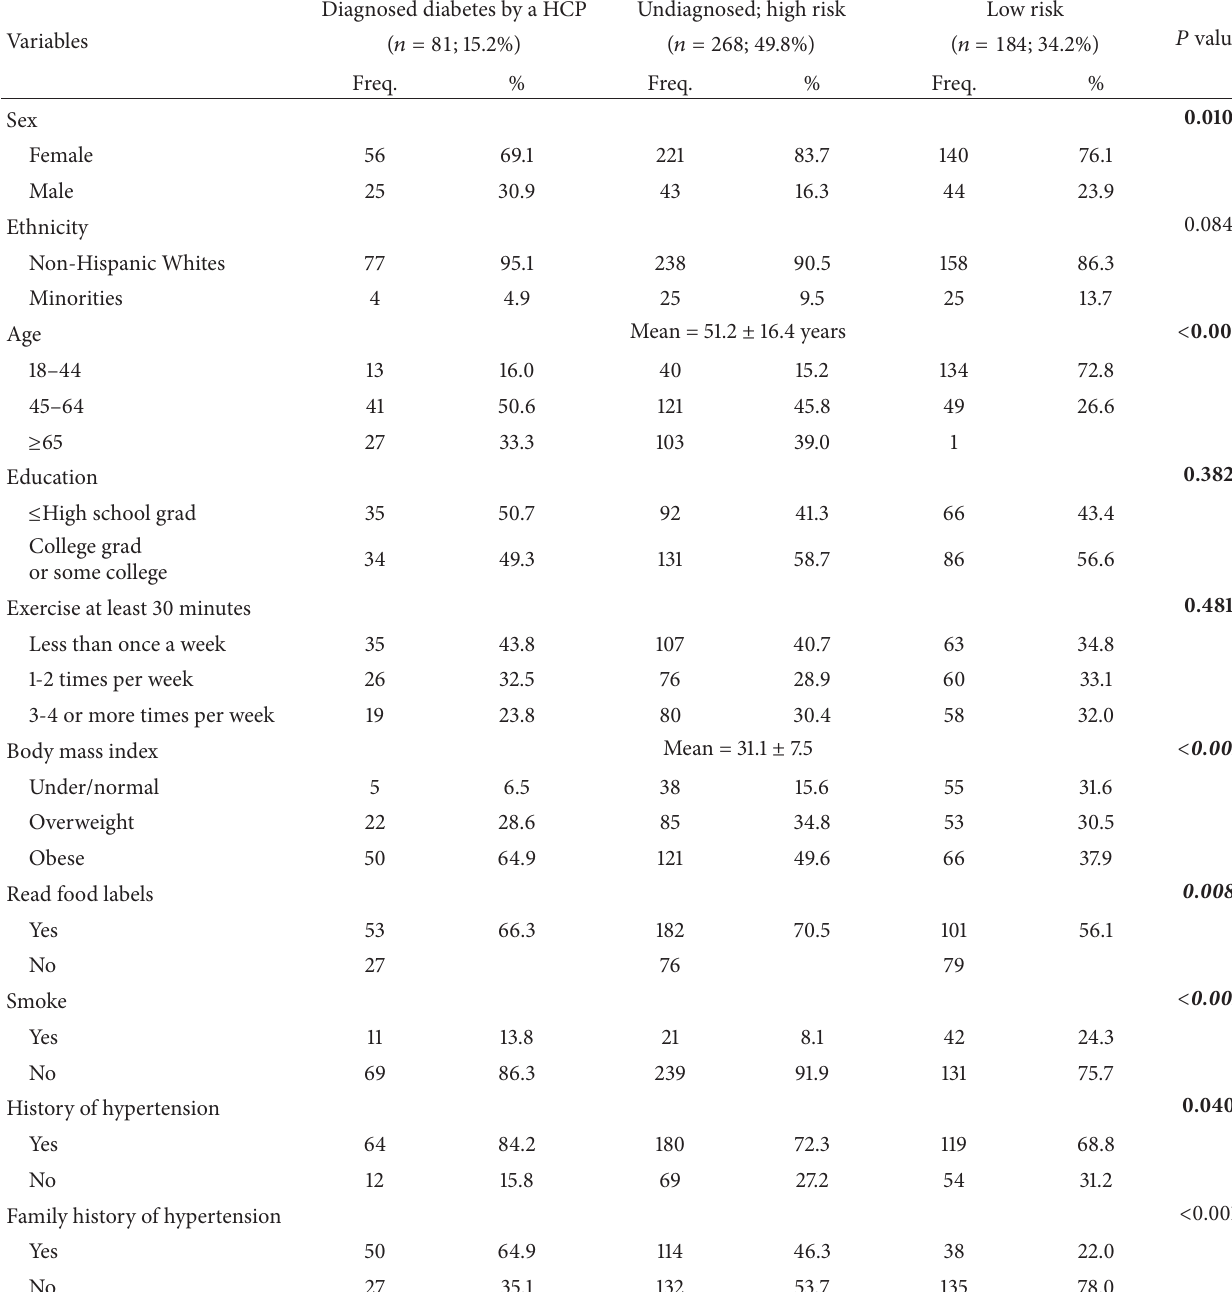
Table 1: Sample characteristics of participants by diagnosed diabetes and undiagnosed high risk and low risk ( 𝑁 = 538 ).